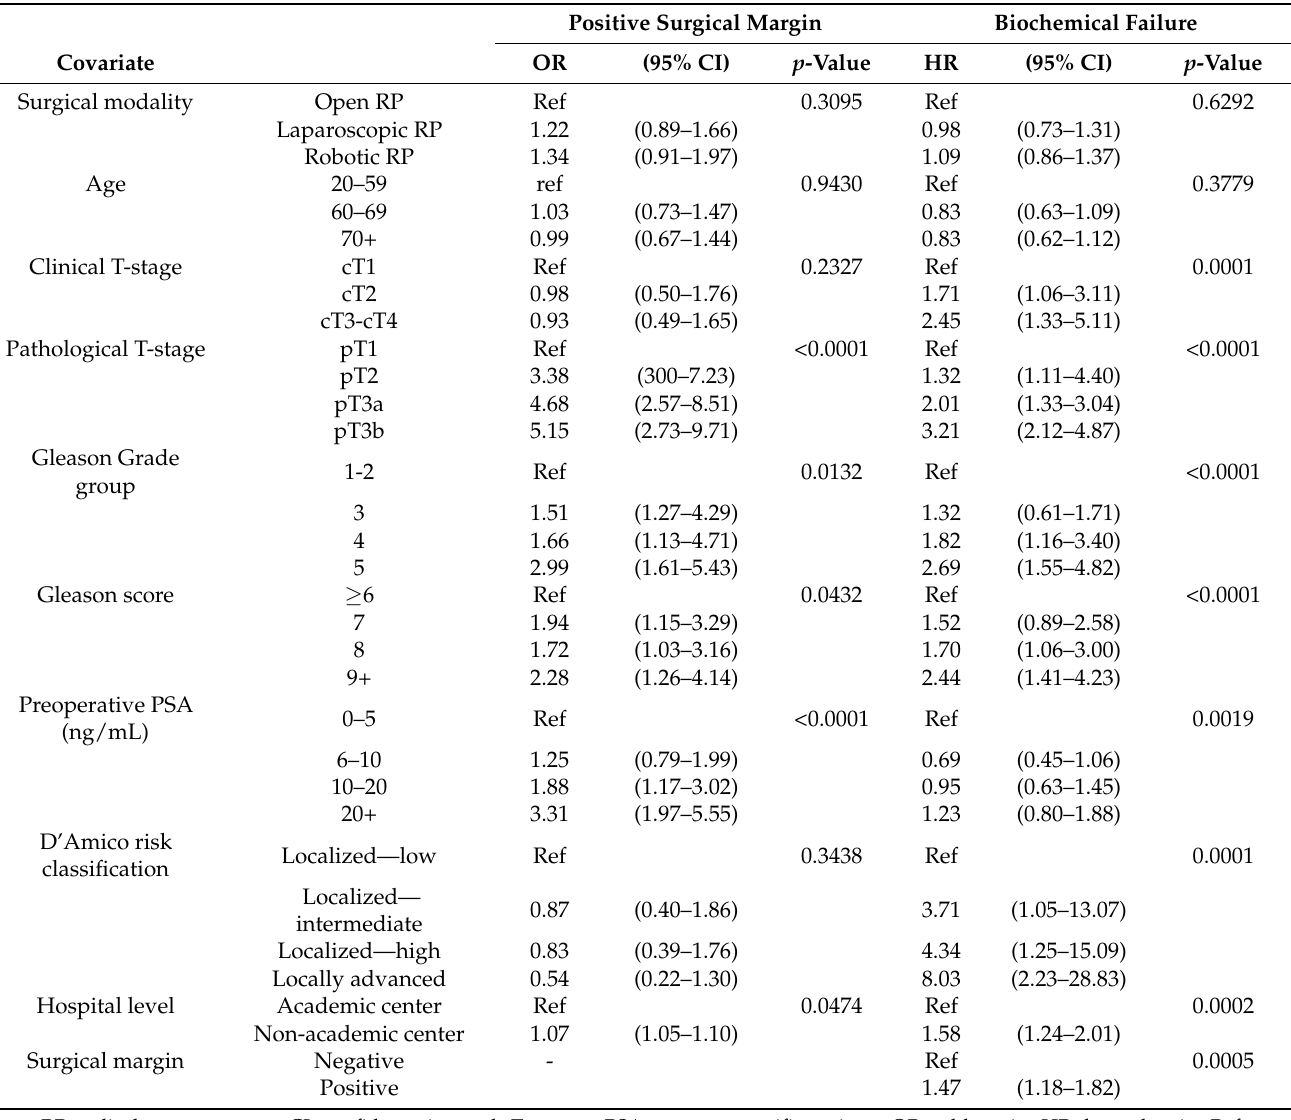
Table 2. Multivariate Analysis of Positive Surgical Margin and Biochemical